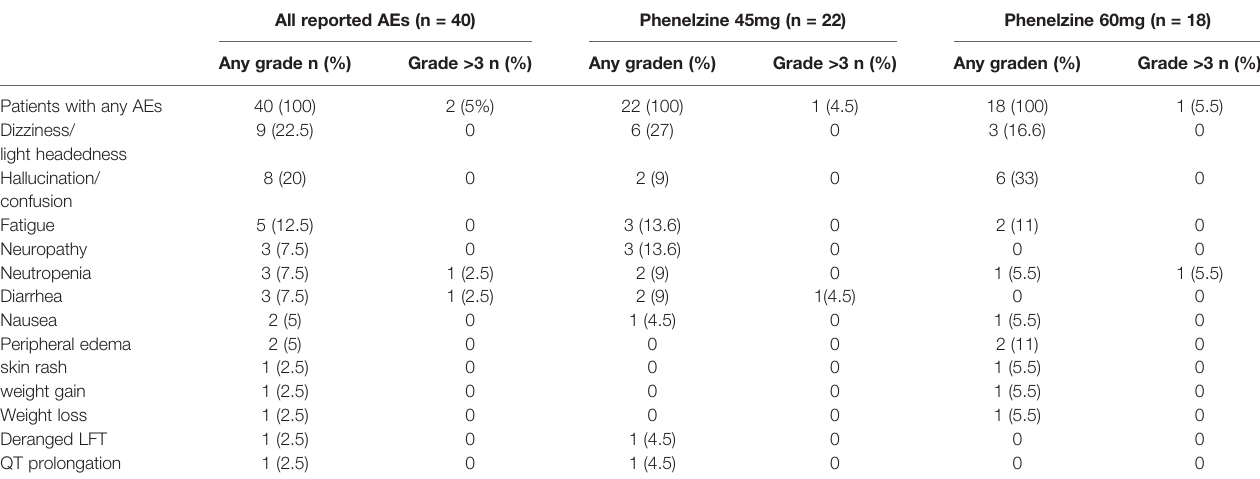
TABLE 2 | Treatment-emergent AEs in the safety analysis according to CTCAE grade. All reported AEs (n =